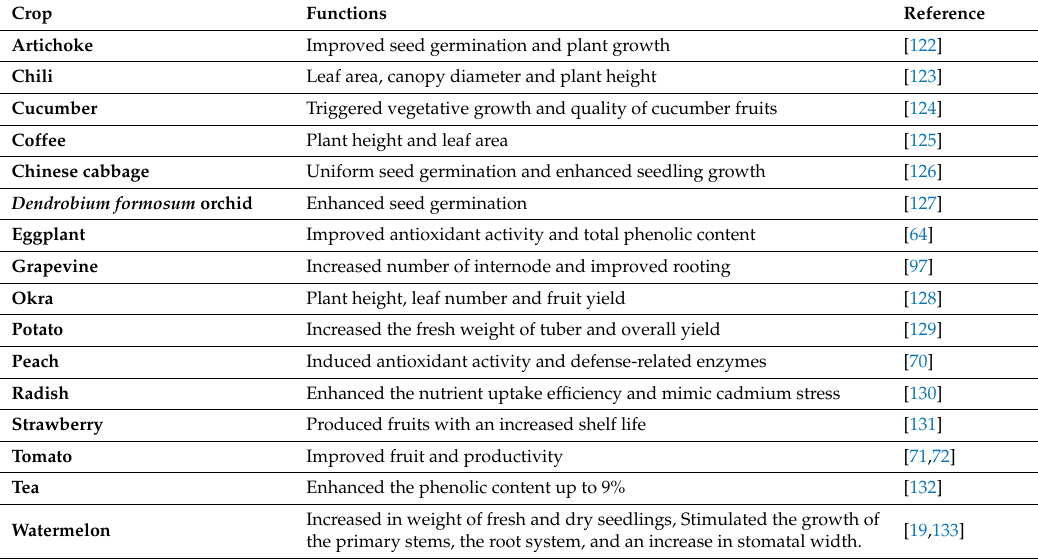
Table 3. Reported studies on chitosan effects on the agronomic traits of horticultural